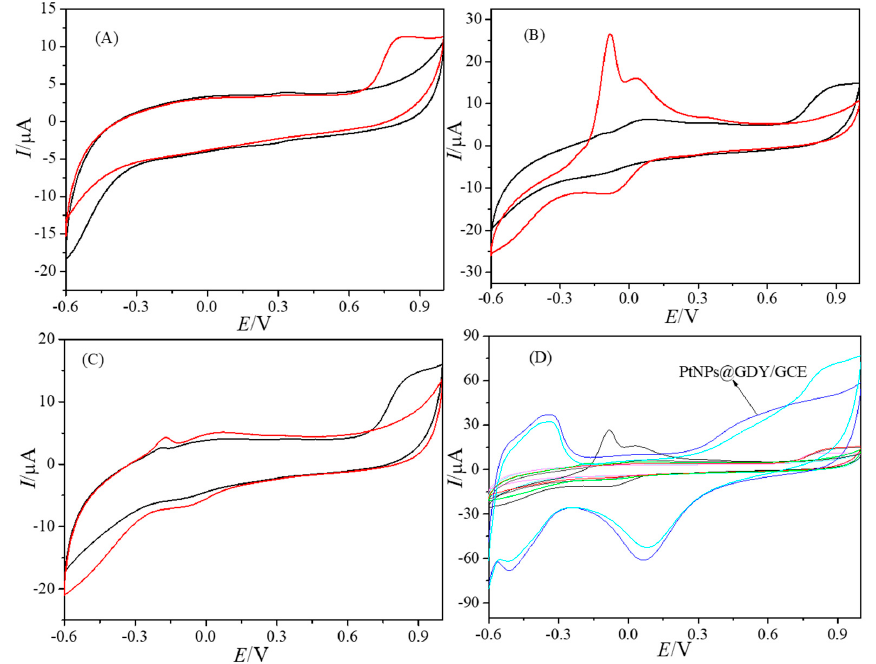
Figure 3. CVs of the bare GCE ( A ), GDY/GCE ( B ), PtCl 62 − /GDY/GCE ( C ), PtNPs@GDY/GCE and the above three modified electrodes ( D ) in 0.1 M PB with the absence and presence of 0.5 mM BPAF.